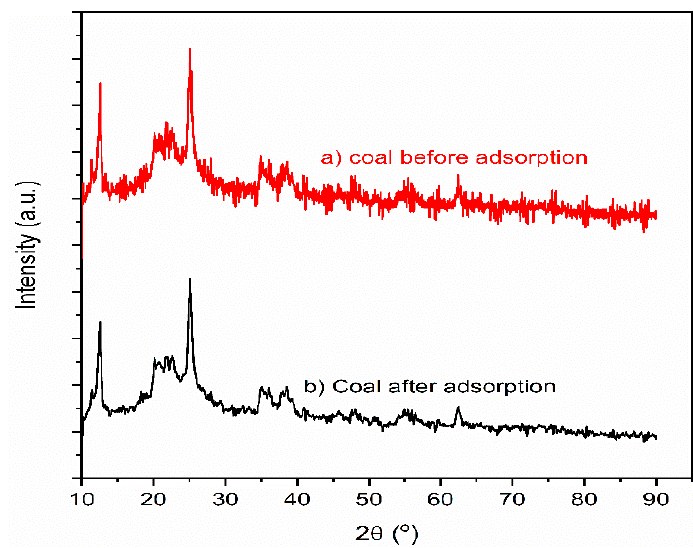
Figure 2. XDR patterns of leftover coal material ( a ) before and ( b ) after adsorption.